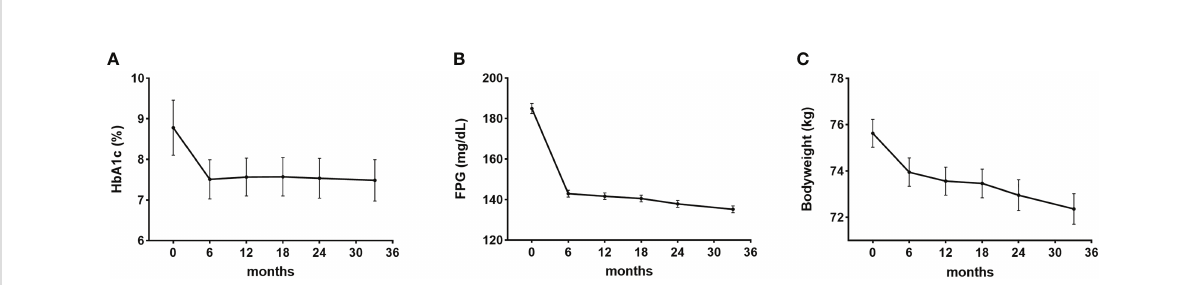
FIGURE 2 Ef fi cacy of dulaglutide. Changes in (A) glycosylated hemoglobin (HbA1c), (B) fasting plasma glucose (FPG), and (C) bodyweight after dulaglutide use. Data are presented as mean ± standard error. All values for 6 – 36 months in each of the panels (A – C) were signi fi cantly different (P < 0.05) compared with the corresponding baseline values.